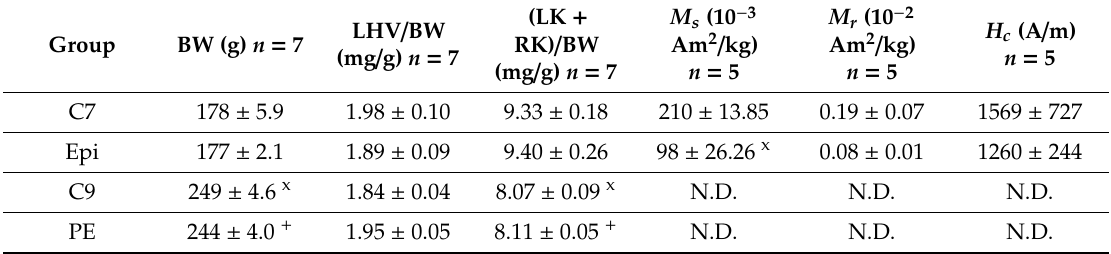
Table 2. Basic biometric parameters and magnetic properties of blood.